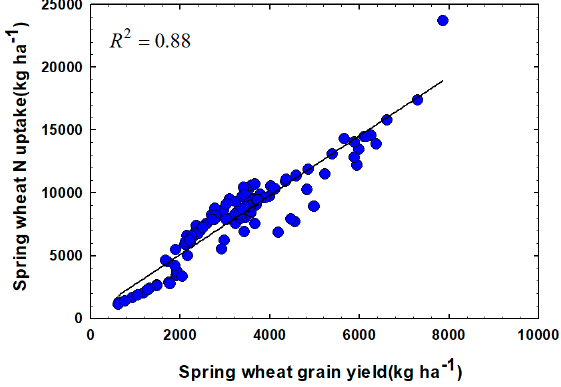
Figure 4. Relationship between N uptake and grain yield of spring wheat, six site-years in Montana.